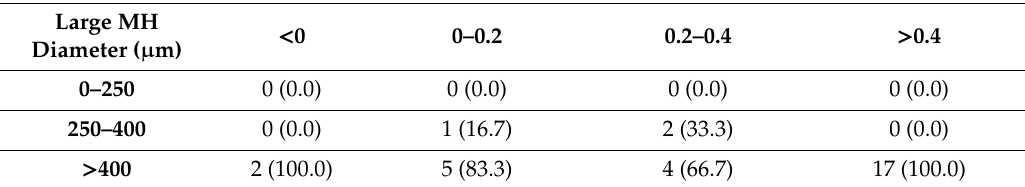
Table 5. Relationship between difference MH diameters and change or improvement in visual acuity .